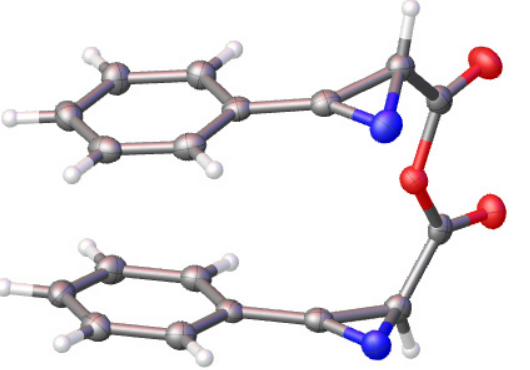
Figure 1. Perspective view of ( RS,SR ) ‐ isomer of anhydride 10a showing thermal ellipsoids at 50% 111 probability level.